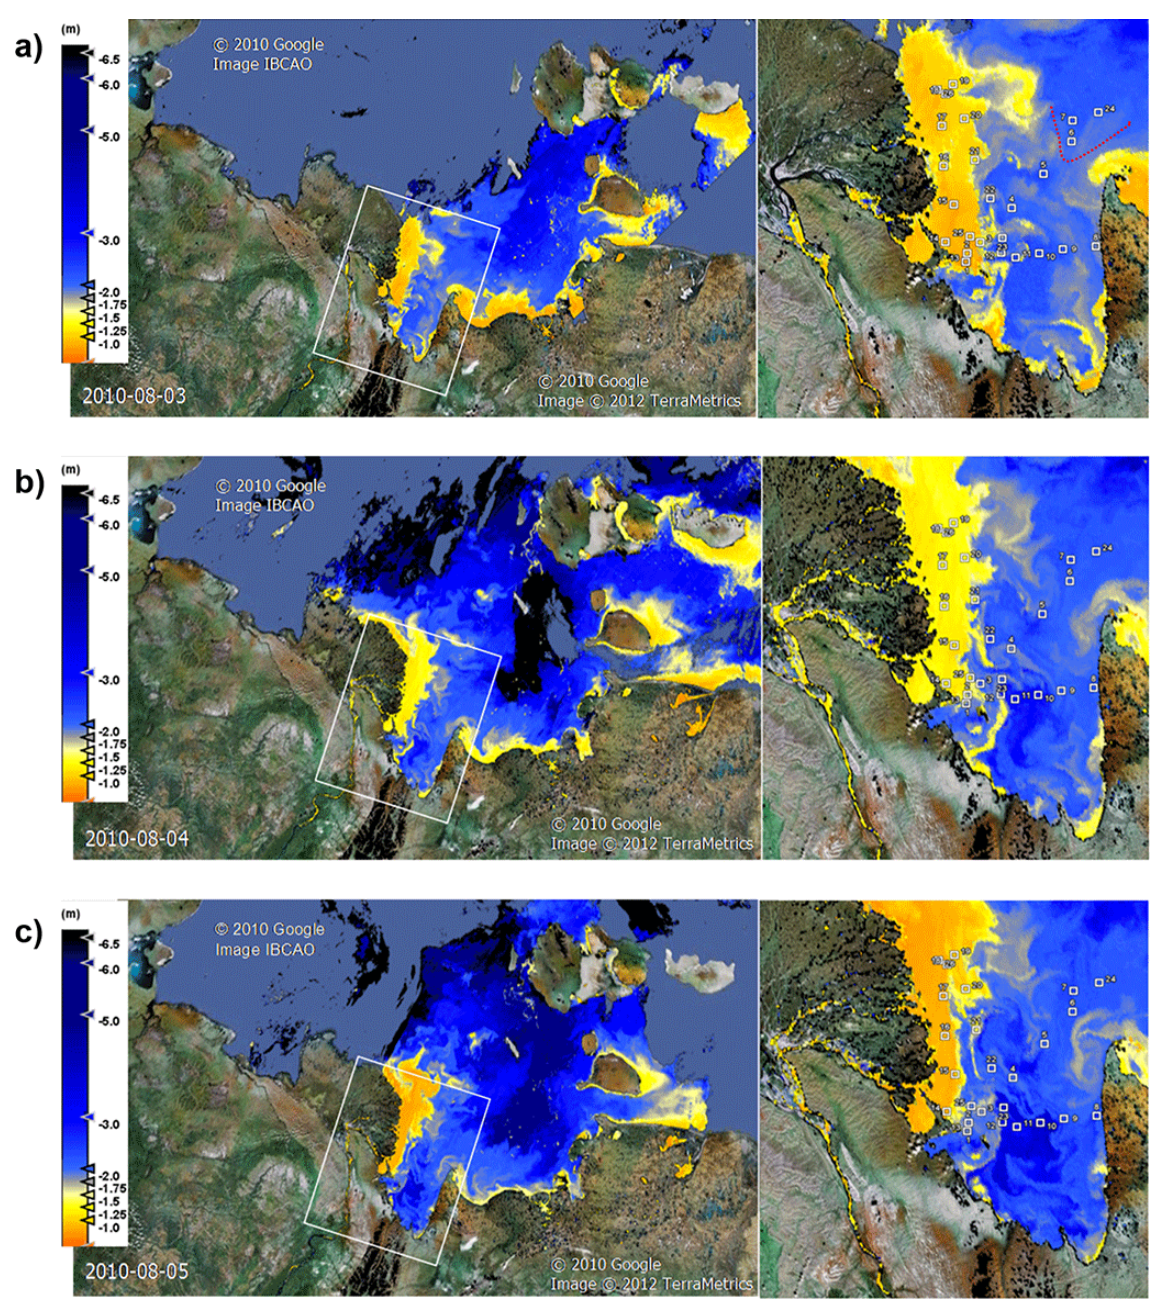
Figure 2. MERIS colour-coded maps of C2R_Z90, the first attenuation depth, of the Buor-Khaya Gulf with the land and detected clouds transparently masked. The transparent masks display the Google Earth ™ land mosaic and the IBCAO bathymetry ( © 2010 Google, Image © 2012 TerraMetrics, Image IBCAO) as background. (a) 3 August 2010; the salinity isoline=8 is schematically displayed as red outline close to the most northeastern L10 stations (6, 7, 24). Southwards, freshwater dominates (salinity < 5), and (b) 4 August 2010 and (c) 5 August 2010 are the cloud-free MERIS acquisitions within the time window of the L10 expedition (from 29 July to 7 August 2010).